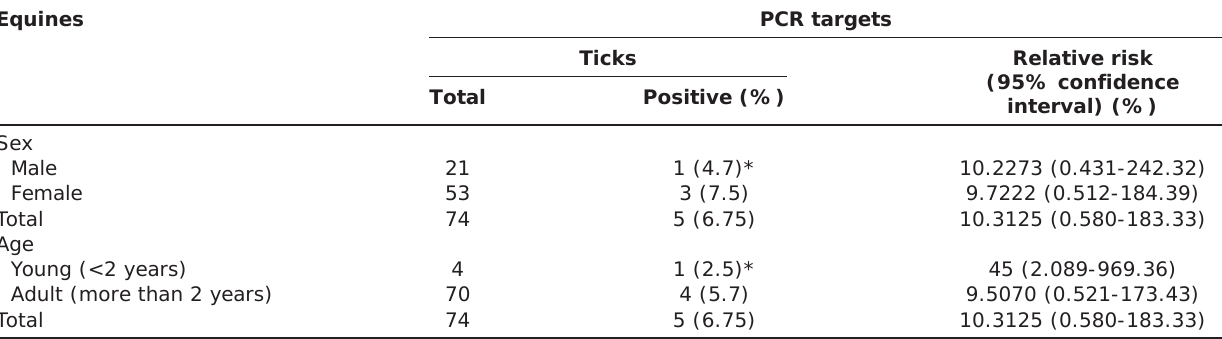
Table-2: PCR amplification targeting T. equi infection in ixodid ticks.